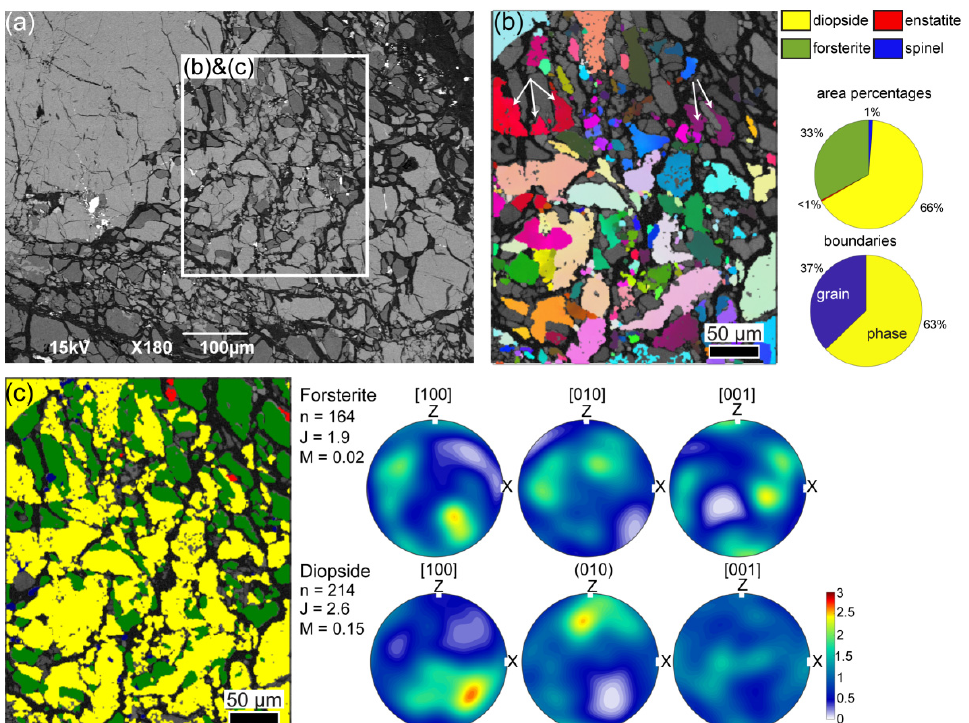
Figure 7. ( a ) BSE image of a cpx porphyroclast with recrystallized tail of olivine and cpx neoblasts. ( b ) Diopside orientation map of the recrystallization tail (ROI33). White arrows show one grain of diopside with irregular boundaries and olivine in between. ( c ) Phase map of the same area as in ( b ). The CPOs of clinopyroxene and olivine are also shown.